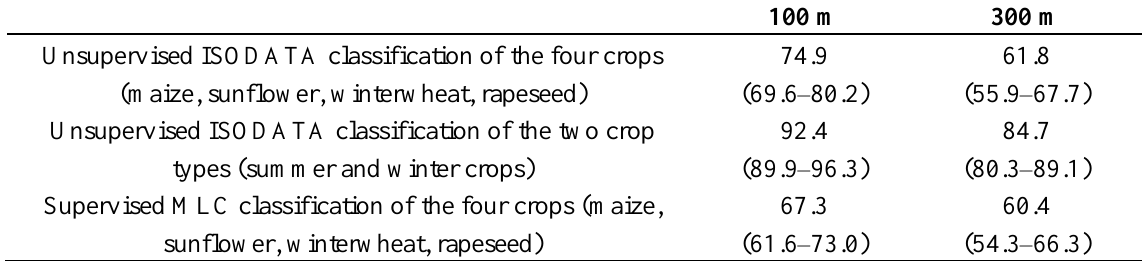
Figure 6. PROBA-V NDVI ( a ) 100 m and ( b ) 300 m time series profiles of four classes from ISODATA clustering and the recoded time series profiles with two classes ( c ) 100 m and ( d ) 300 m. Table 7. Overall classification accuracies for PROBA-V NDVI time-series against independent validation data (n = 275). Confidence intervals at the 5% significance level are shown in parentheses [38,39]. The differences between the overall accuracies of 100 m and 300 m were statistically significant at the 0.05 probability